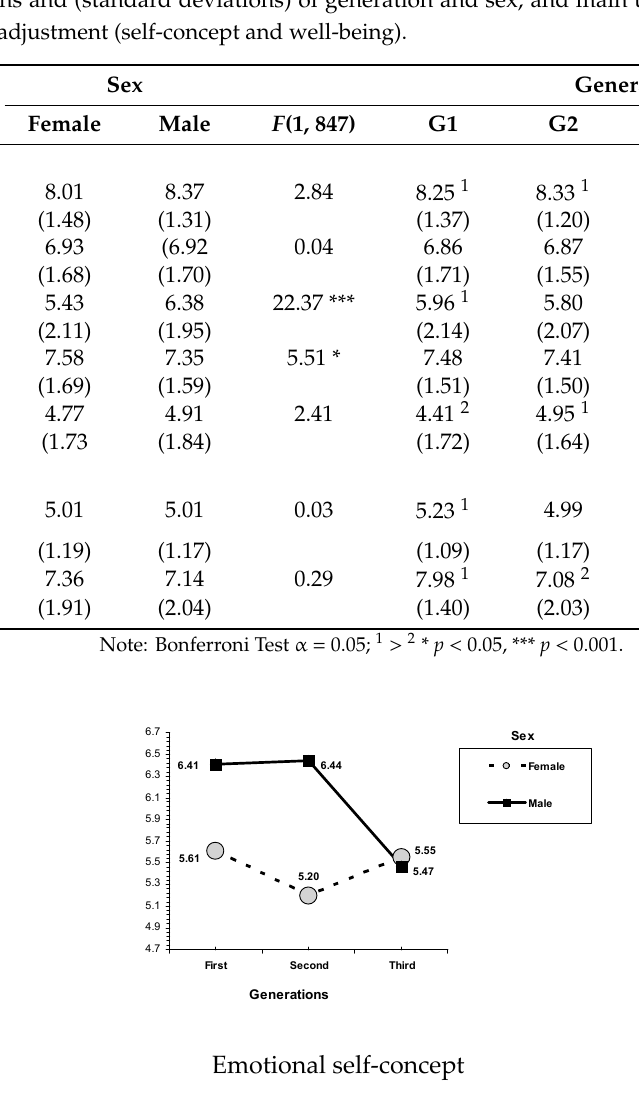
Figure 3. Interactions of sex and generation. Emotional self-concept.